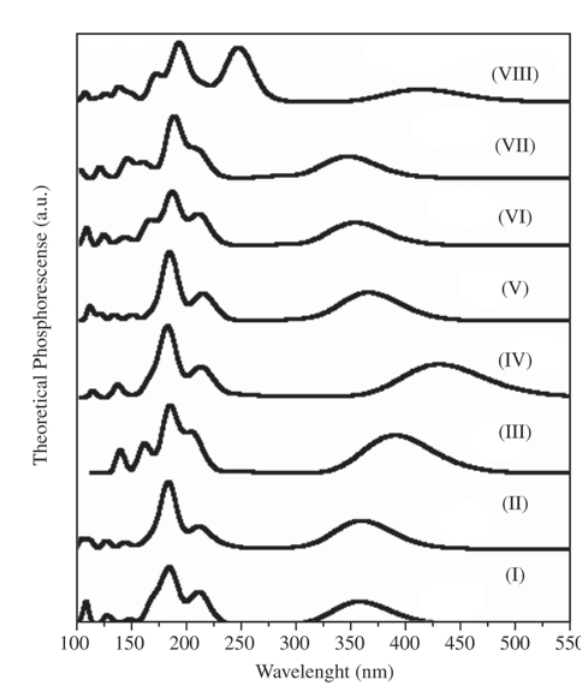
Figure 5 . Theoretical UV-vis spectra of molecules I to VIII (Table 1) calculated for optimized geometries by DNdM-INDO/S-CI (phos- phorescence spectra) by PM3/CI method.